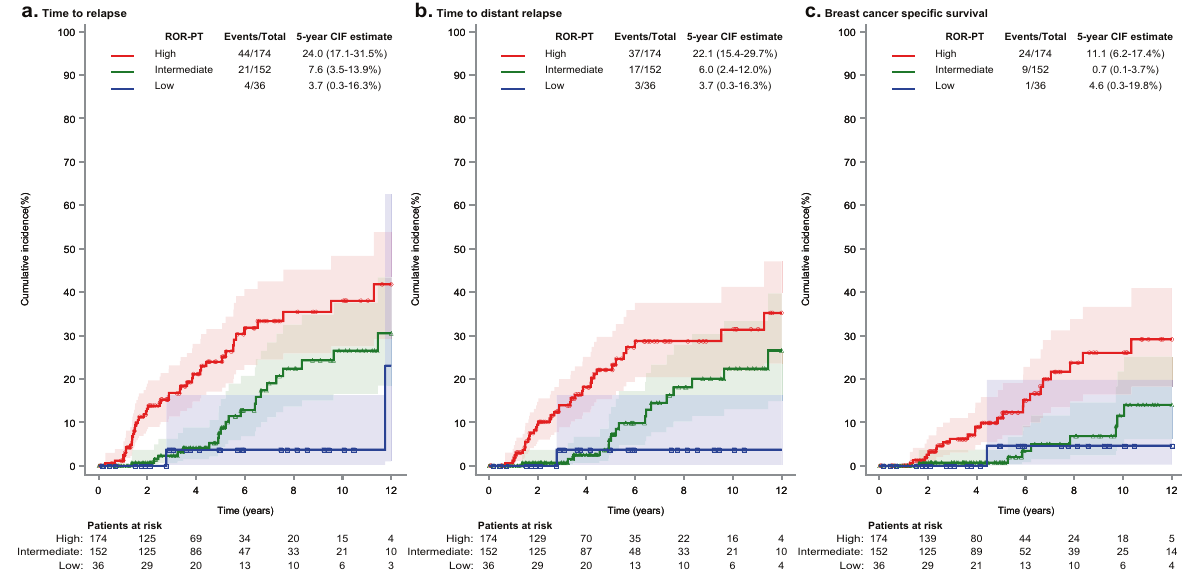
Fig. 2 ROR-PT-trained cumulative incidence of clinical outcomes by risk category. a ROR-PT-trained risk classi fi cation for Time to Relapse; b ROR-PT-trained risk classi fi cation for Time to Distant Relapse; c ROR-PT-trained risk classi fi cation for Breast Cancer Speci fi c Survival. Cumulative incidence rates for low (blue line), intermediate (green line), and high (red line) ROR-PT-trained results with corresponding 95%CI (shaded areas) estimated by cumulative incidence function accounting for deaths not preceded by a distant relapse as competing risks. Total events/risk group (Events/Total) represent all events observed during follow up (up to 12 years). CIF = 5-year cumulative event frequency (percent) at 5 years with estimated 95% con fi dence intervals (95% CI).